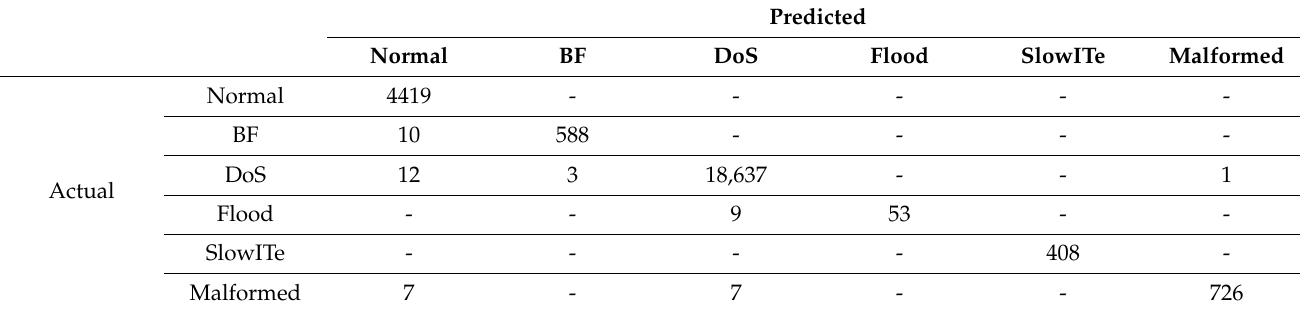
Table 5. Confusion matrix when a source port index is not used.